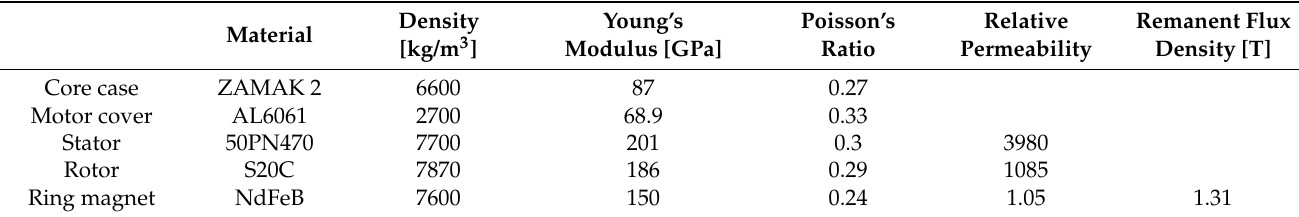
Figure 3. BLDC 2D model for electromagnetic simulation. Table 2. Properties of the parts of the BLDC